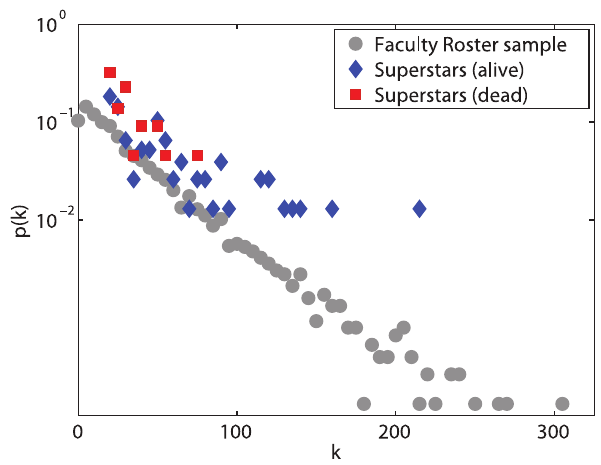
Figure 5. Degree distributions of three groups of scientists. The degree distributions of 7555 samples from the Faculty Roster, 77 eminent life scientists and 21 suddenly died eminent life scientists are shown in the figure. The average degree of the three groups are 31.83, 56.56 and 35.29.